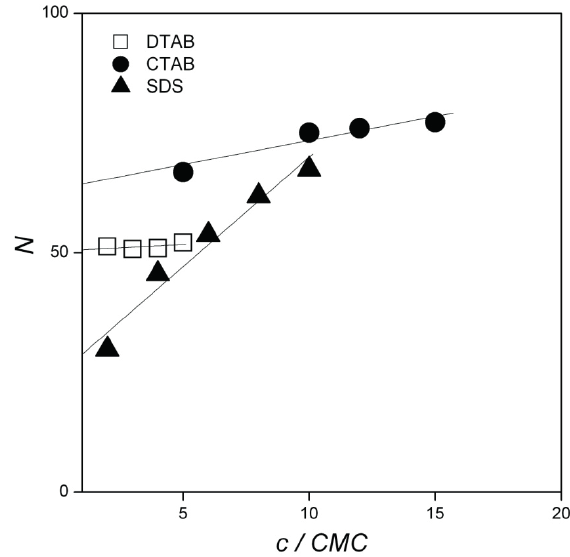
Figure 5: Concentration dependence of aggregation number N for CTAB, DTAB and SDS micelles as determined from fluorescence decay measurements at the excitation wavelength 381 nm.